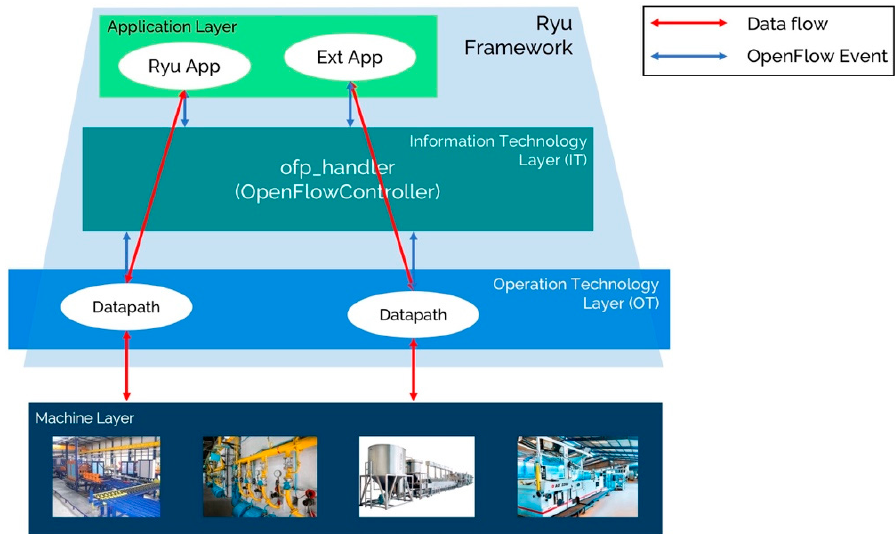
Figure 2. Ryu internal implementation architecture.